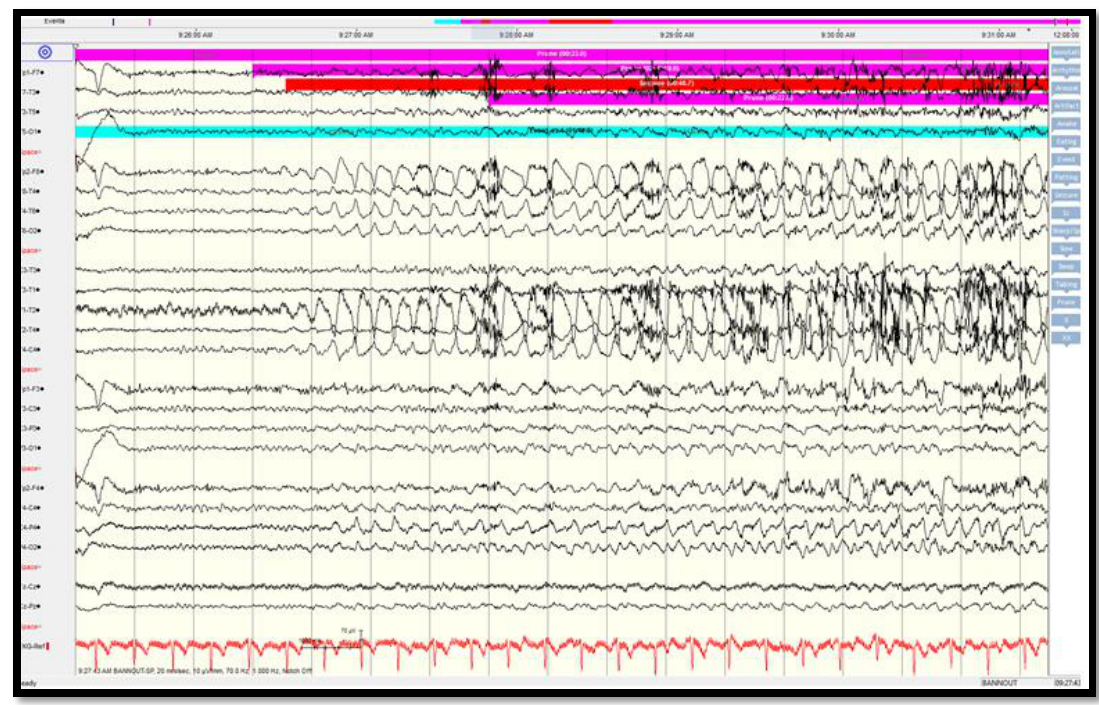
Figure 6. Scalp EEG recording showing right anterior temporal evolving 2–3 Hz ictal rhythm (arrows).